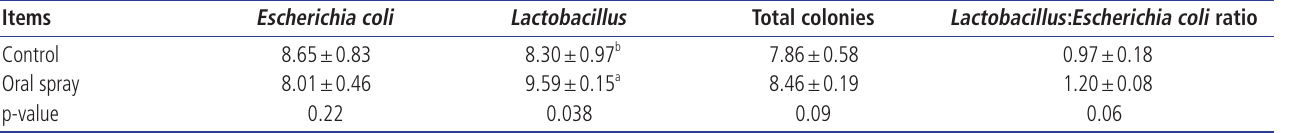
CFU, colony forming units. Data was expressed as mean±standard deviation (n = 4). a,b Means within the same column lacking a common superscript differ